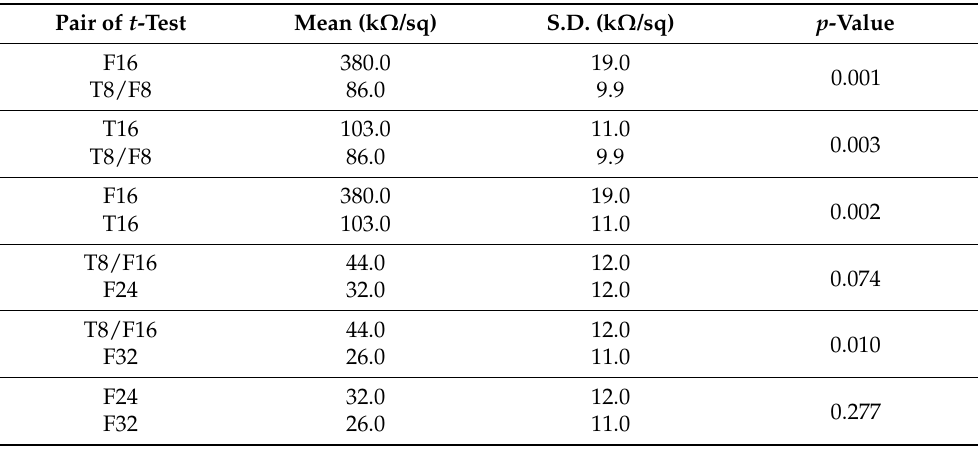
Table 3. Results of the paired t -test analysis of PAN-based composite films with various types of carbon nanomaterials and contents.